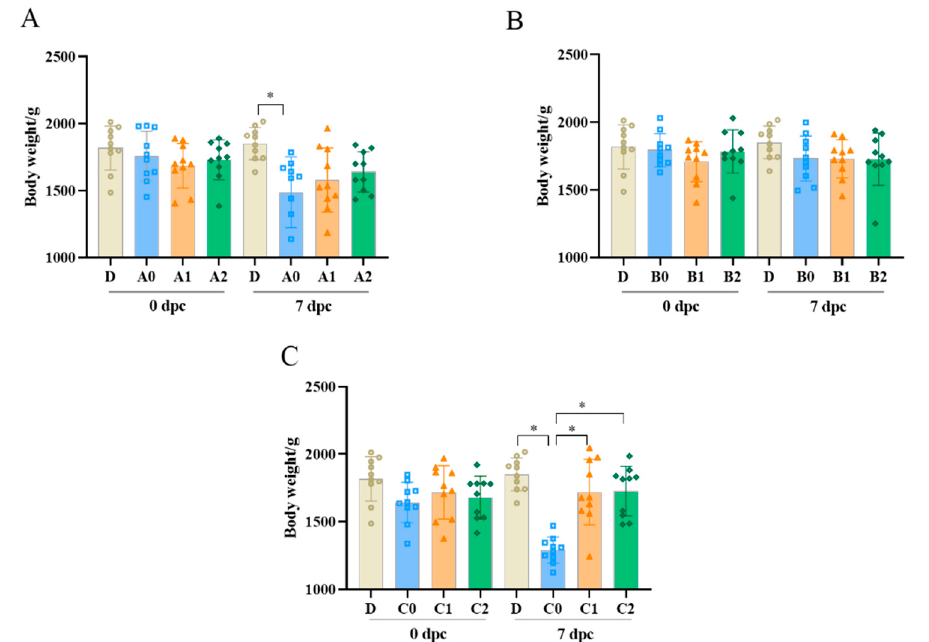
Figure 3. Body weight of chickens after challenge with Av. paragallinarum. The chickens’ individual body weights were measured before and 7 days after challenge with 2019-HB65 ( A ), 2019-HB68 ( B ), and 2020-JS80 ( C ) at 130 days old (n = 10). Data in bar graphs indicate means ± standard deviations. * p < 0.05.